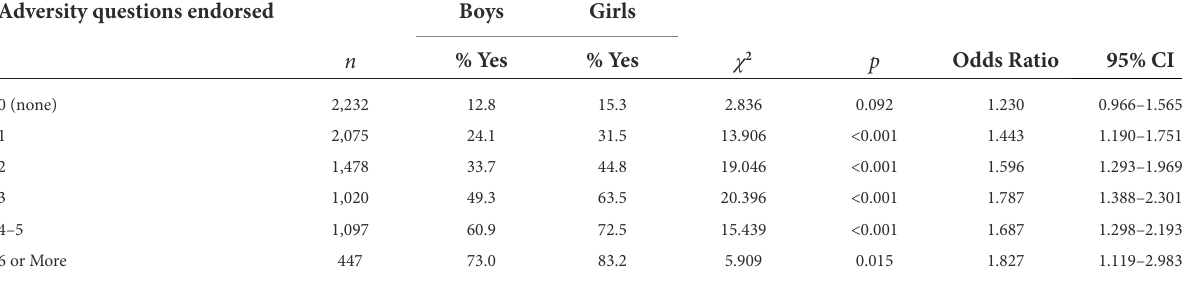
TABLE 5 Comparing percentages of girls and boys with cognitive impairment stratified by the number of adversity items endorsed. Adversity questions